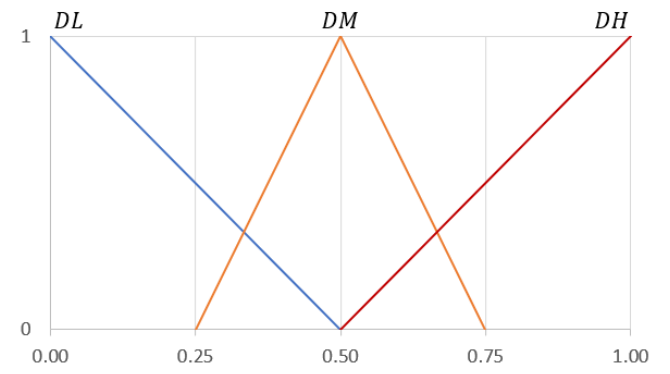
Figure 2. Fuzzy sets for the demand of the customer i .